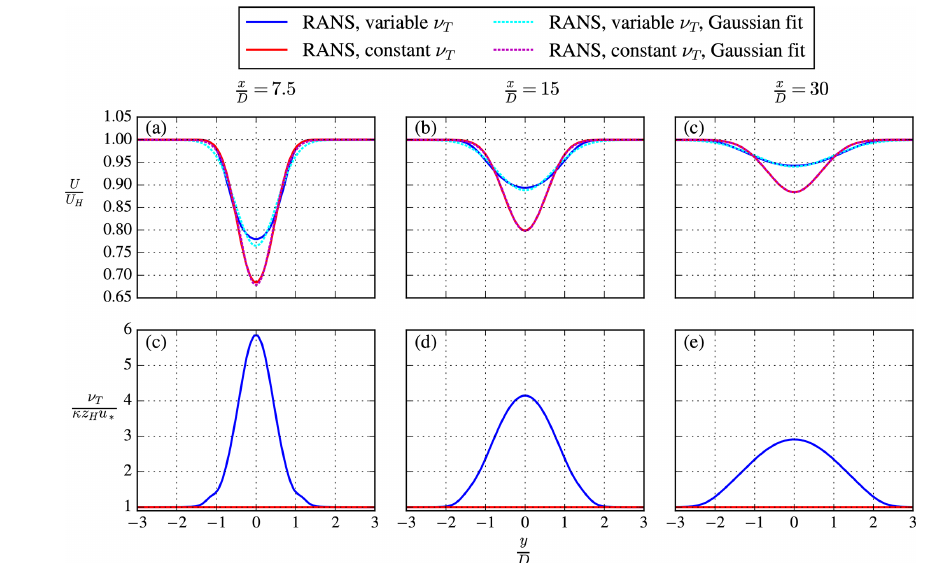
Figure A1. Velocity deficit (a–c) and eddy viscosity (d–f) of a single wind turbine simulated in RANS.